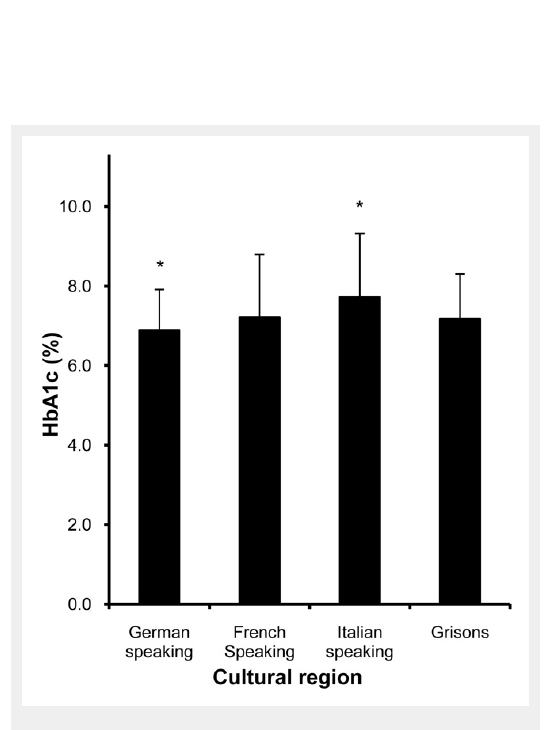
HbA1c measurements at the time of the survey in different cultural regions of Switzerland. * indicates regions in which HbA1c measurements differed from the other regions, p <0.001.